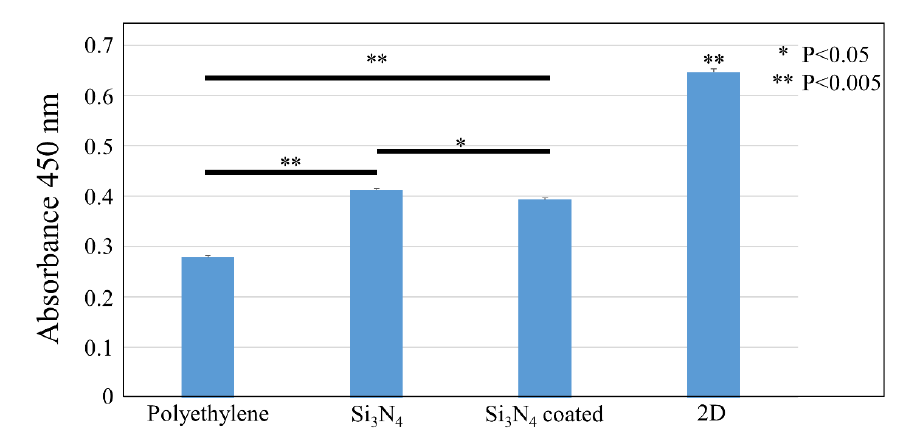
Figure 9. Biological assay (absorbance at 450 nm) of all the investigated samples after in vitro SaOS-2 cell exposure.